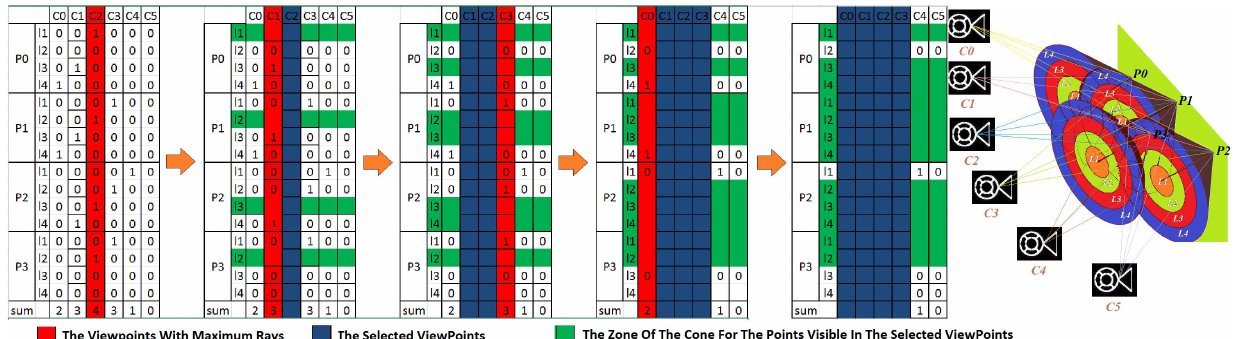
Figure 2. Visibility matrix and the procedure of clustering and selecting vantage viewpoints ( left ), the cone of points and viewpoints ( right